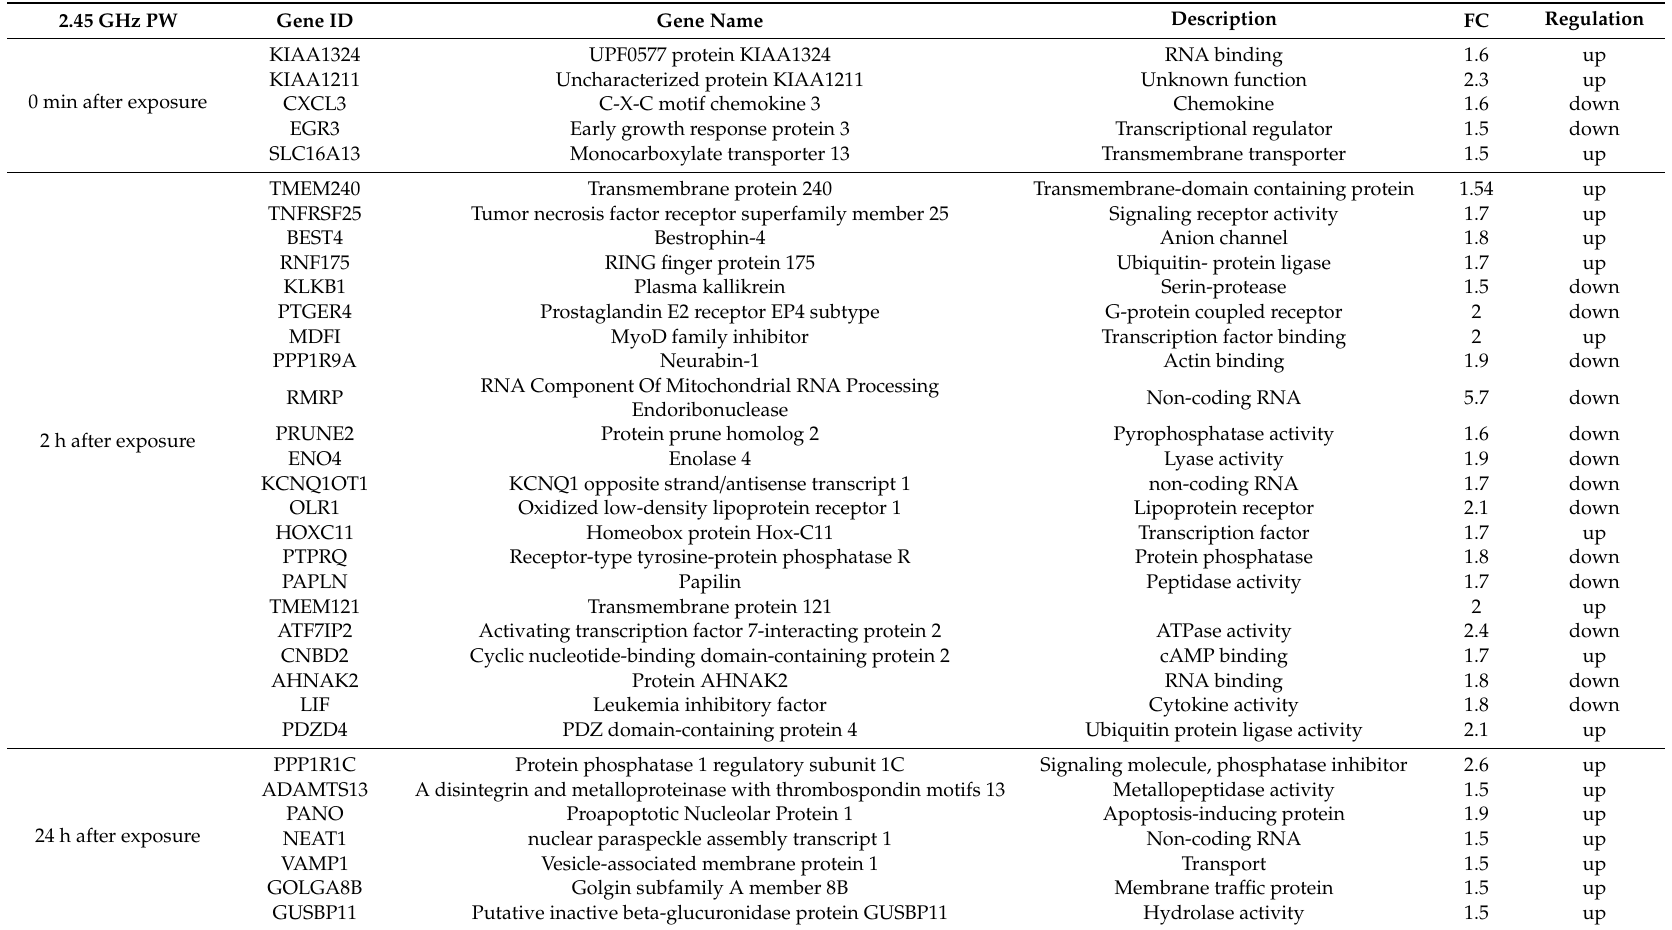
Table 3. List of genes di ff erentially expressed between exposed and sham samples after exposure to 2.45 GHz PW. The table includes gene name, gene function, fold change (FC), and